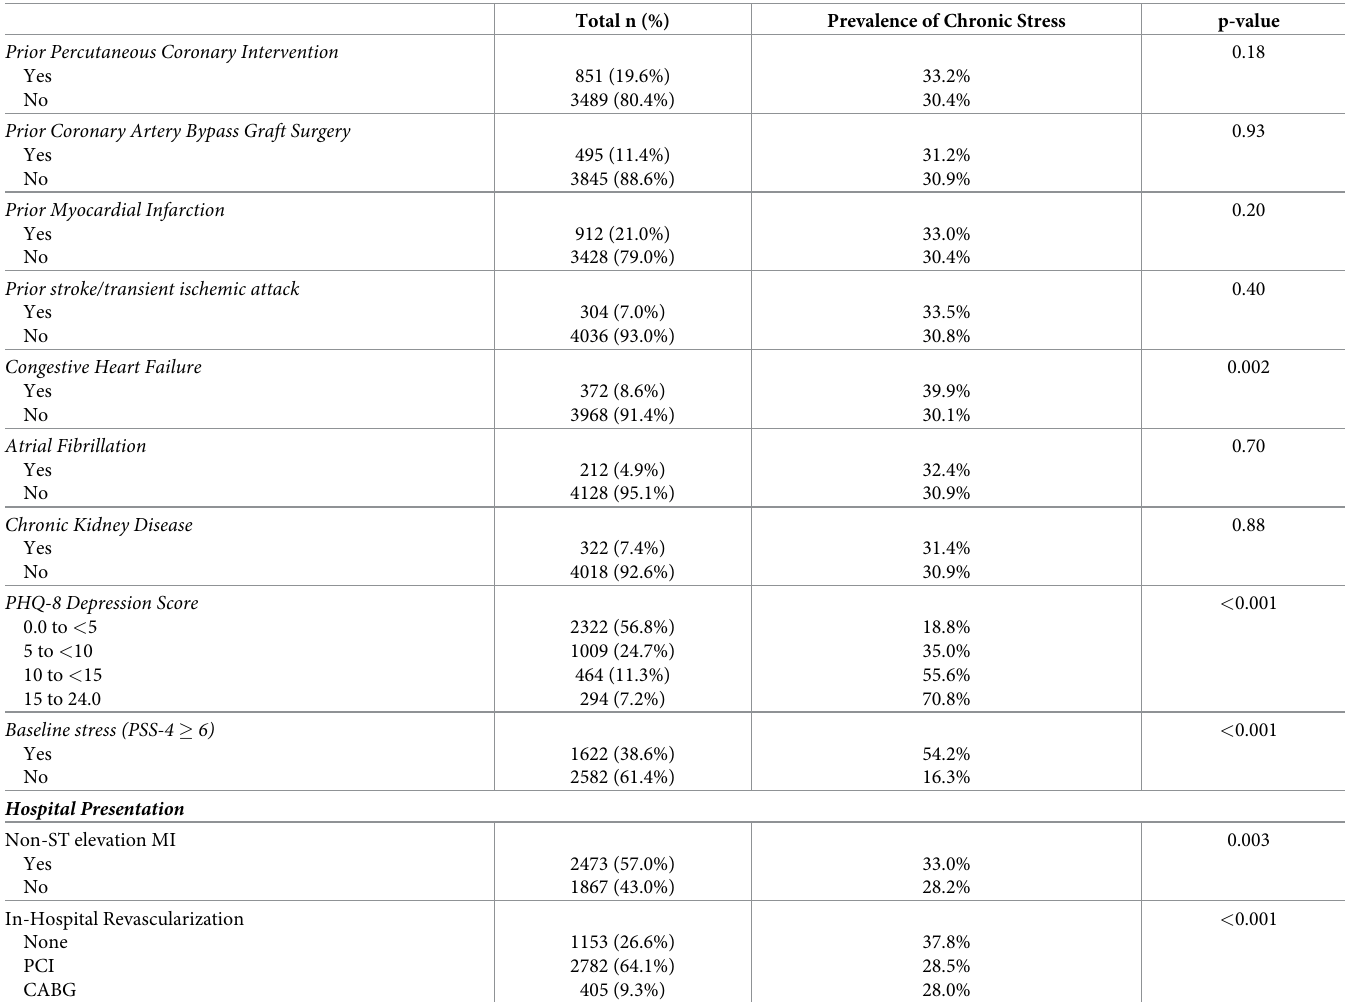
chronic stress over 12-month follow-up. S1 Fig details the calibration plot for the 6-item model in the TRIUMPH study. These were age, sex, economic burden related to medical care, general SES, current smoker, and ESSI score. The bootstrapped-validated c-statistic for the final model (including all the 6-items) was 0.75 (S1 Fig). The c-statistic for the final model, applied to the validation cohort (PORTRAIT study) was 0.77 and calibration was excellent (Fig 2). S1 Table gives the intercept and coefficient information for all the covariates in the final regression equation.